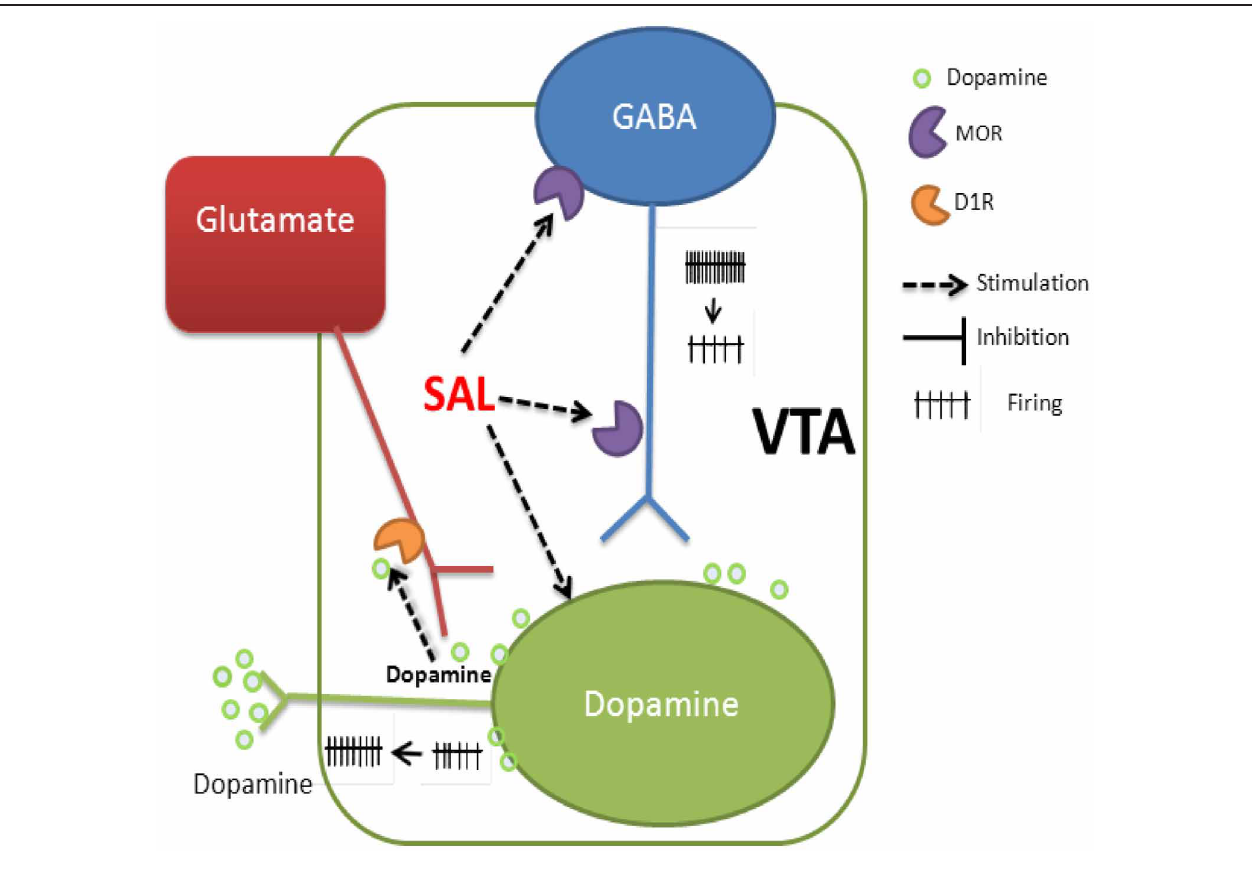
FIGURE 1 | Schematic representation of the mechanisms underlying SAL’s excitation of putative DA neurons in rat Pvta. (1) Depolarizing the membrane and increasing the firing rate. (2) Activation of MORs on the